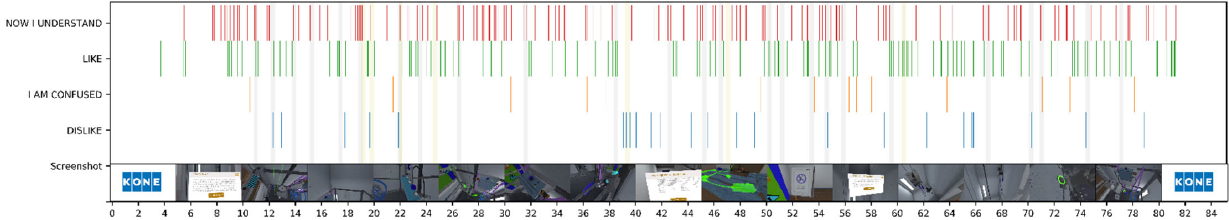
Figure 6. The timeline of reactions collected during the remote training session.